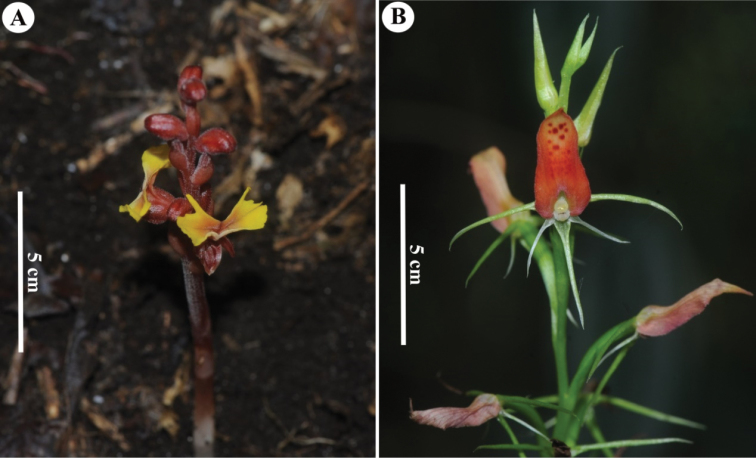
New records discovered from Myanmar AOdontochilus
poilanei (Gagnep.) Ormerod BCryptostylis
arachnites (Blume) Hassk. Photos by Ye Lwin Aung.